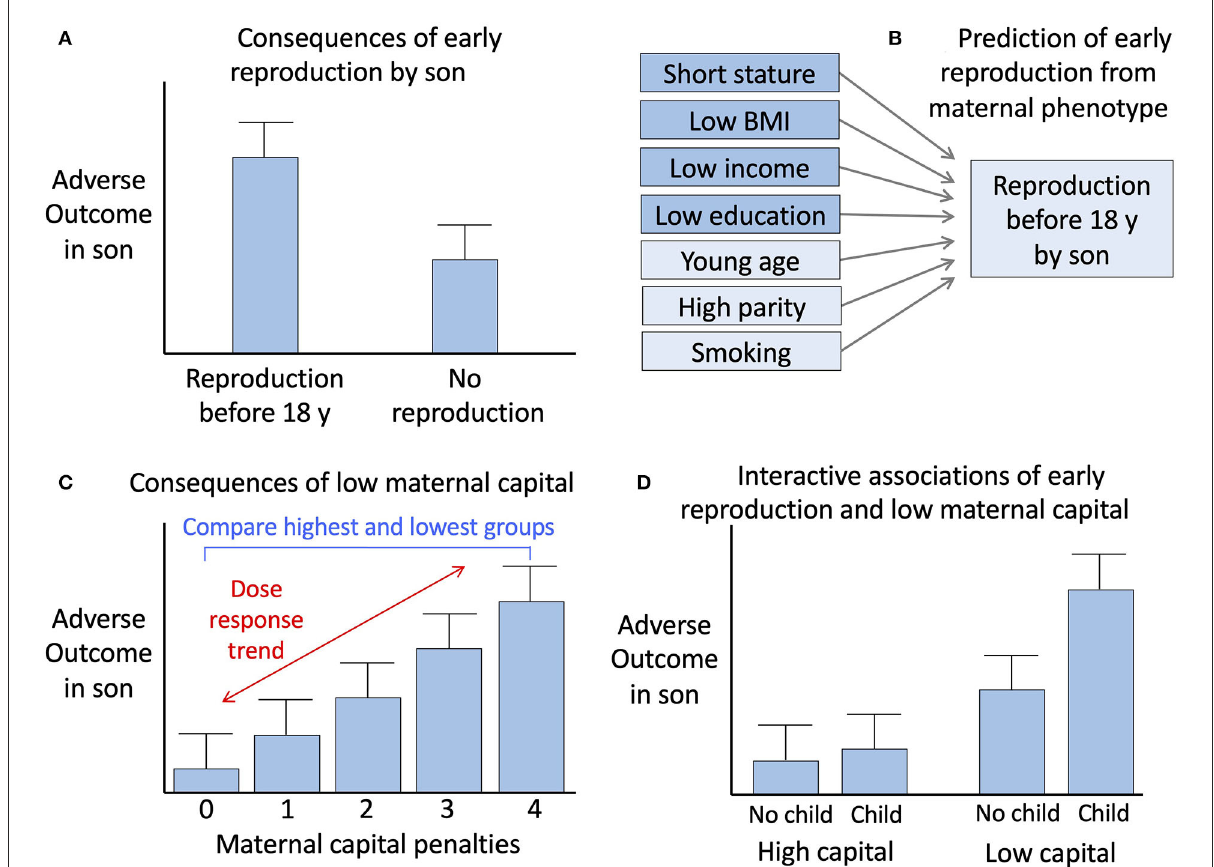
FIGURE1 Conceptual diagram of the analysis. (A) Comparison of outcomes between sons who reproduced before 18 years vs. those who did not. (B) Prediction of early reproduction by sons from components of maternal capital, including those used to generate the maternal capital index and three other maternal traits. (C) Analysis of the association of adverse son outcomes with maternal capital, involving assessment of a dose-response trend across the range of maternal capital penalties. (D) Analysis of the interactions of early son reproduction and low maternal capital with adverse son outcomes. Reproduced with permission from reference